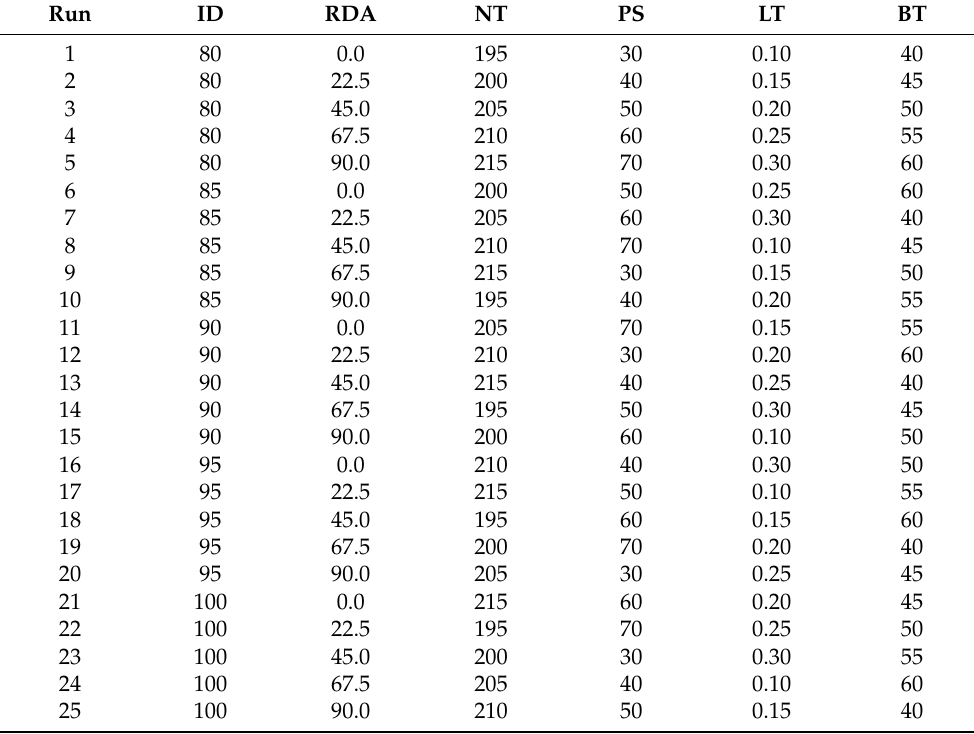
Table 1. Taguchi L25 Design: Control parameters and levels.